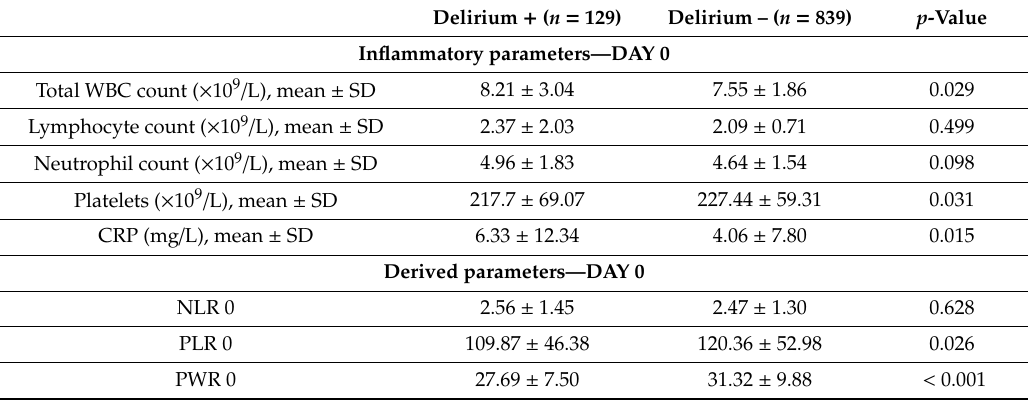
Table 4. Mean levels of pre-operative inflammatory markers and derived parameters for patients with and without POD after CABG. POD, Postoperative delirium; CABG, coronary artery bypass grafting. Delirium + ( n = 129) Delirium – ( n = 839) p -Value Inflammatory parameters—DAY 0 Total WBC count ( × 10 9 / L), mean ±